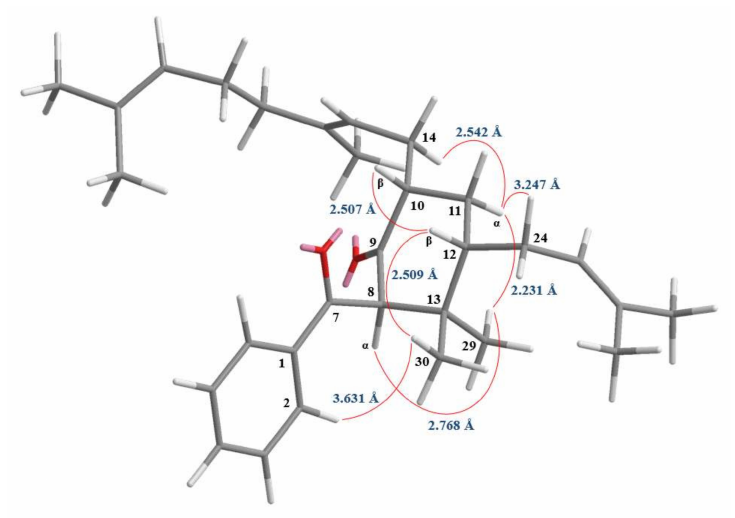
Figure 6. Selected ROESY correlations and relative configuration of 3